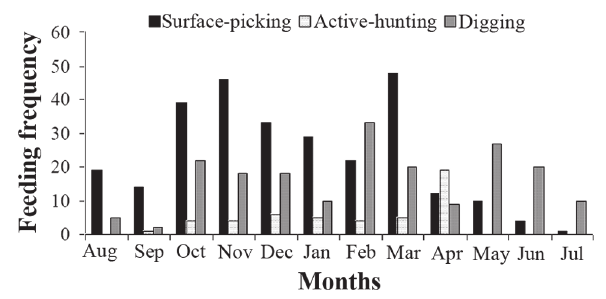
Fig. 1. Observed frequency of foraging tactics of Brycon devillei in the RPSP between April 2006 and July 2009.